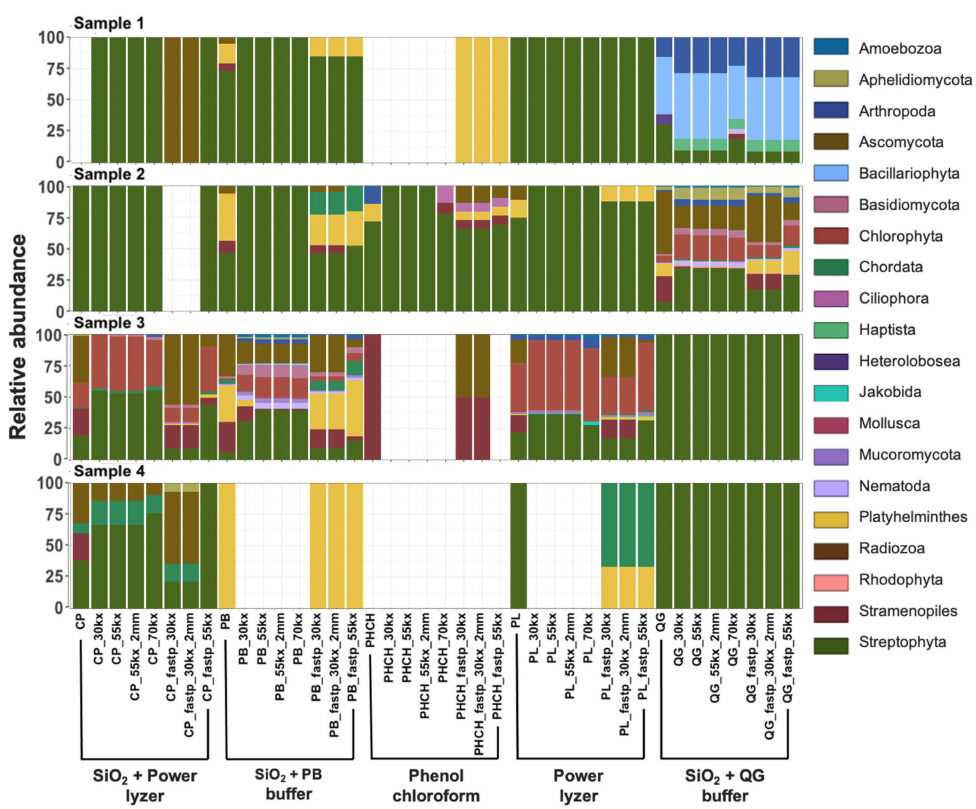
Figure 5. Taxonomic profile for the Eukaryota domain at phylum level of collapsed reads of the four samples extracted with five DNA extraction methods and preprocessed using eight bioinformatic pipelines, obtained by aligning collapsed reads to SILVA SSU 132 as reference